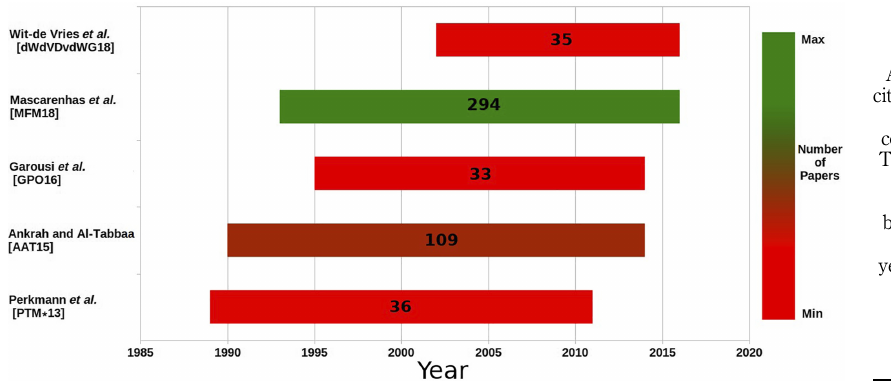
Figure 2. A visualisation of the citation distribution for university – industry collaboration surveys. The number of papers each review surveys are indicated on the bars and indicated by the colour map. The year axis indicates the timespan of the references. See Section 2